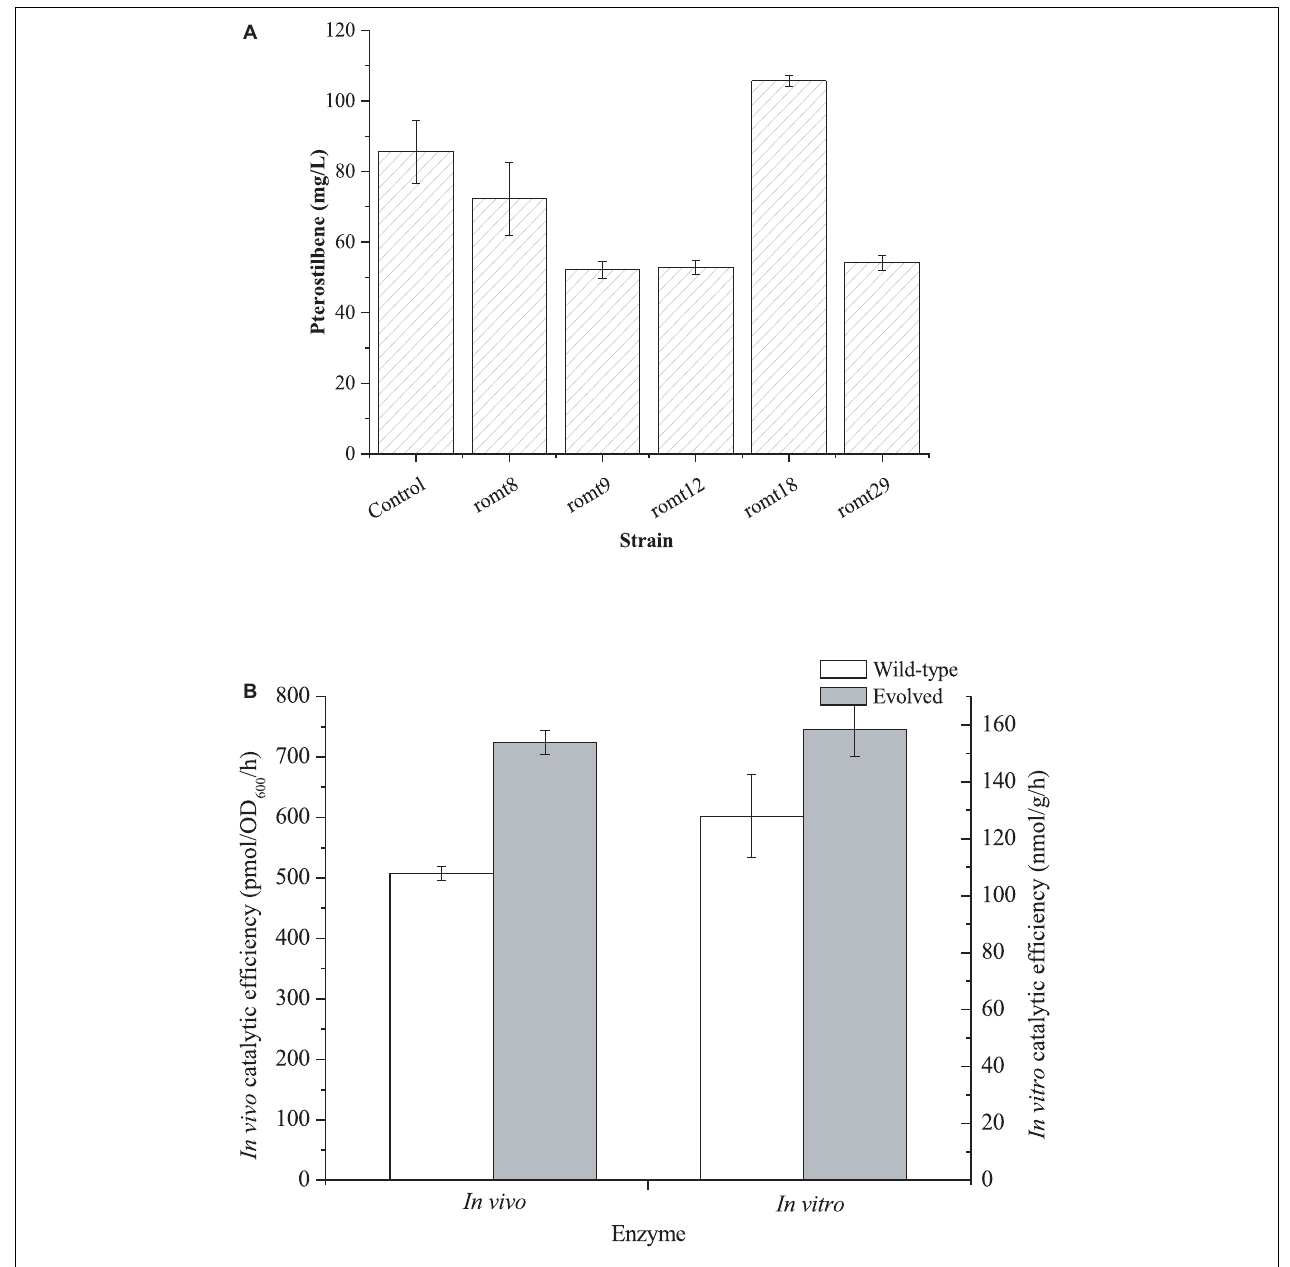
FIGURE 4 | (A) Production of pterostilbene from resveratrol by E. coli BW25113 harboring the mutant plasmids of pZBK-romt. E. coli BW25113 harboring pZBK-romt was set as the control. (B) In vivo and In vitro catalytic efficiency of the evolved ROMT and its wild-type enzyme. In vivo activity was defined as the pterostilbene forming rate of the whole resting cells and In vitro activity was defined as t the pterostilbene forming rate of the crude extract. The data represent means of three replicates and error bars represent standard deviations.